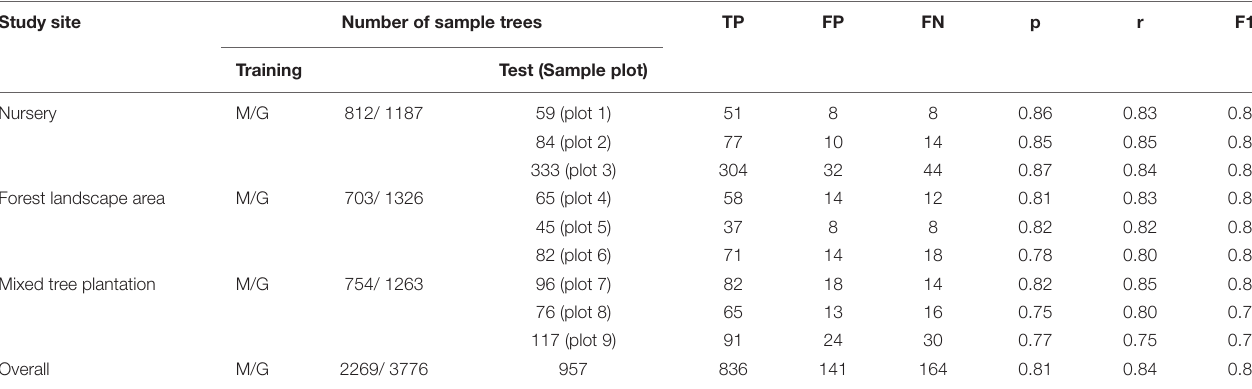
TABLE 2 | Accuracy assessment of ITC detection by our deep learning method for the three forest plot types in the nursery, forest landscape area and mixed tree plantation. Study